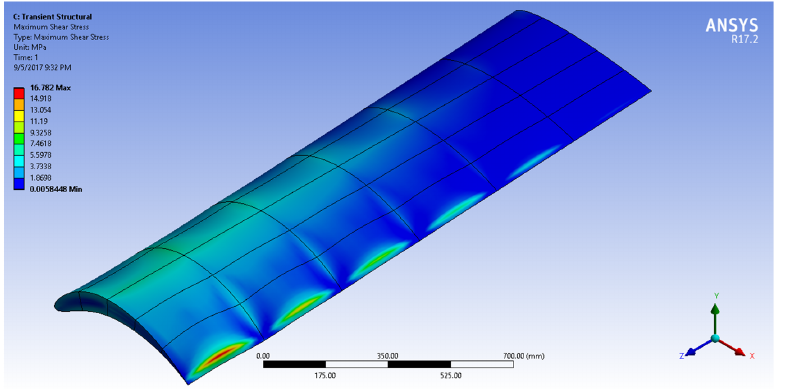
Figure 17. Output (maximum shear stress) distribution to morph NACA2410 to NACA8410 along the wing.